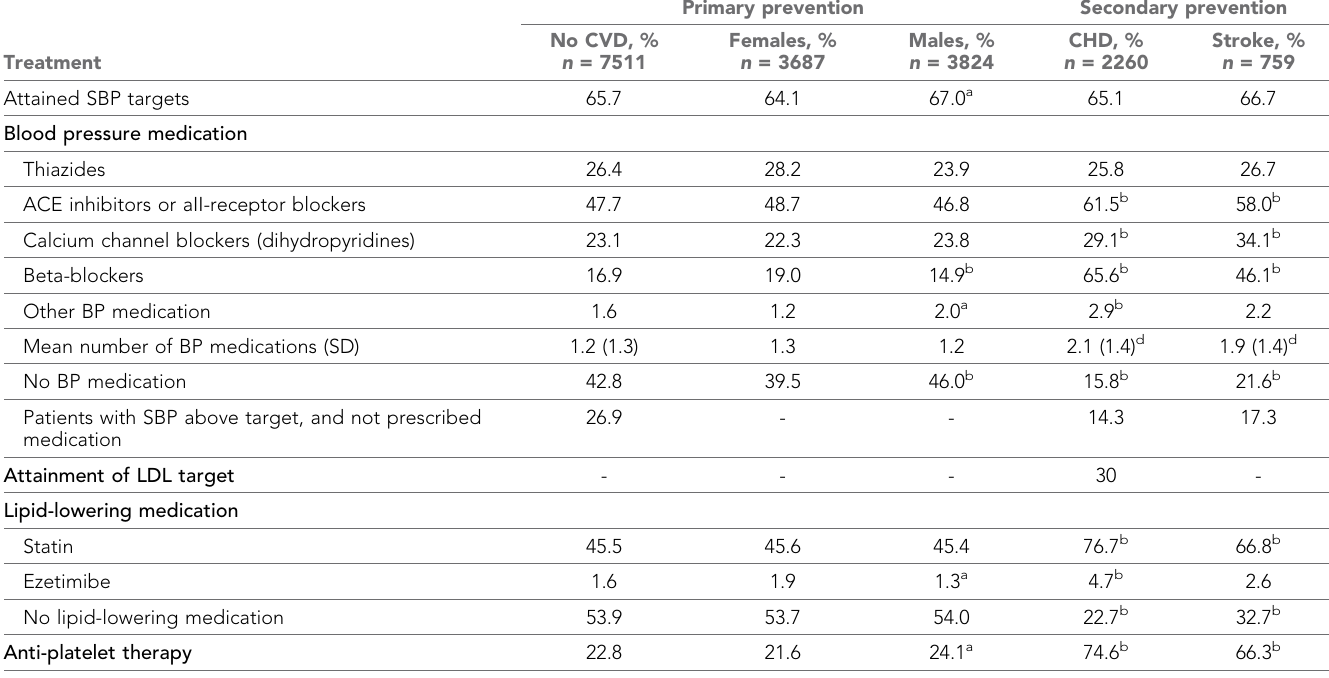
Table 3. Prescriptions during the last 15 months for primary and secondary prevention in patients with type 2 diabetes, CHD, and stroke.